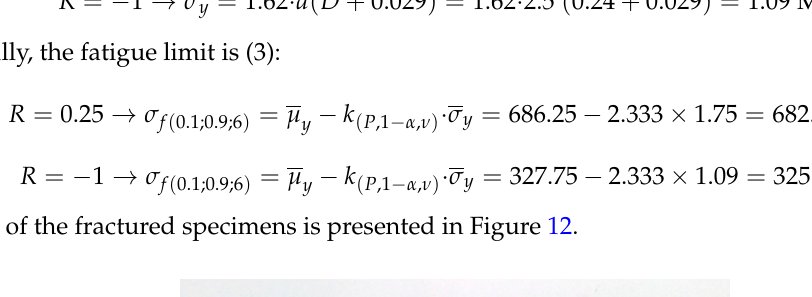
Figure 12. Fractured specimen (from the fatigue process, R = 0.25).